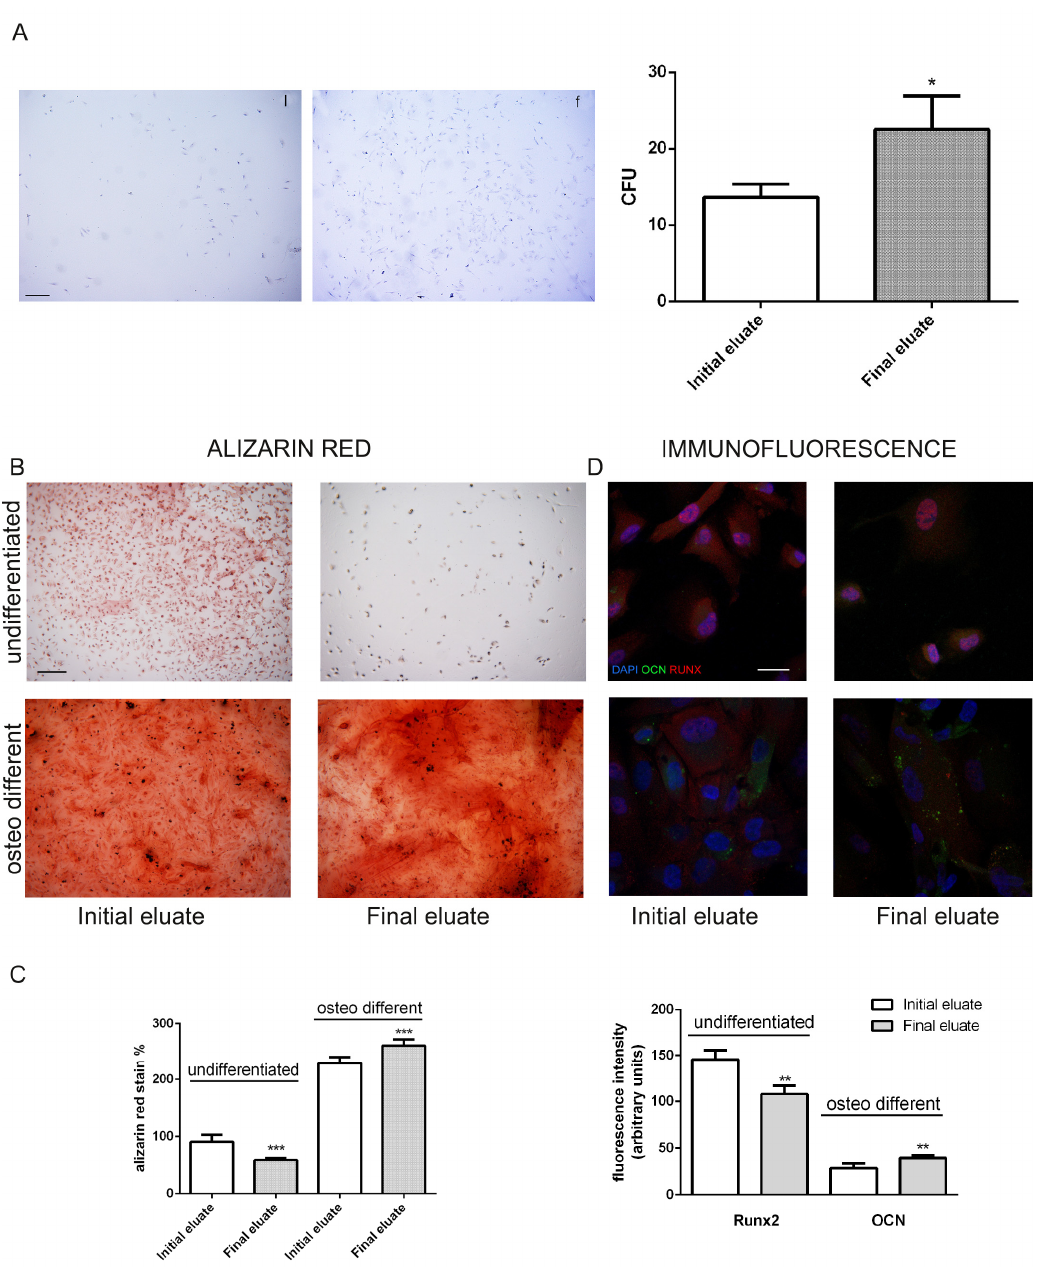
Figure 5. Evaluation of clonogenic and osteogenic differentiation potential of hAFSCs fractions. ( A ) hAFSCs derived from initial or final eluates were compared for proliferation capability. Representative images of colonies and the relative graph of the number of colony forming units (CFU) obtained. Bar = 100 μ m. * p value < 0.05. ( B ) Differentiation capability of initial or final eluates into the osteo mesenchymal lineage. Osteogenic differentiation after three weeks of exposure to osteogenic medium. Evaluation of calcium deposition in the extracellular matrix through Alizarin Red staining: the intensity of red staining is related to the calcium presence typical of mineralizing tissue. Bar = 100 μ m. ( C ) The graph shows the absorbance measured with spectrophotometer of the solubilized alizarin staining. *** p value < 0.001. ( D ) Representative confocal images of initial or final eluates of hAFSCs, exposed or not to osteogenic medium, labelled with DAPI (blue), anti-osteocalcin (OCN) in green and anti-Runx2 in red. Bar = 10 μ m. The graph shows the fluorescence intensity of Runx2 in not differentiated samples and OCN for differentiating condition. ** p value < 0.01.